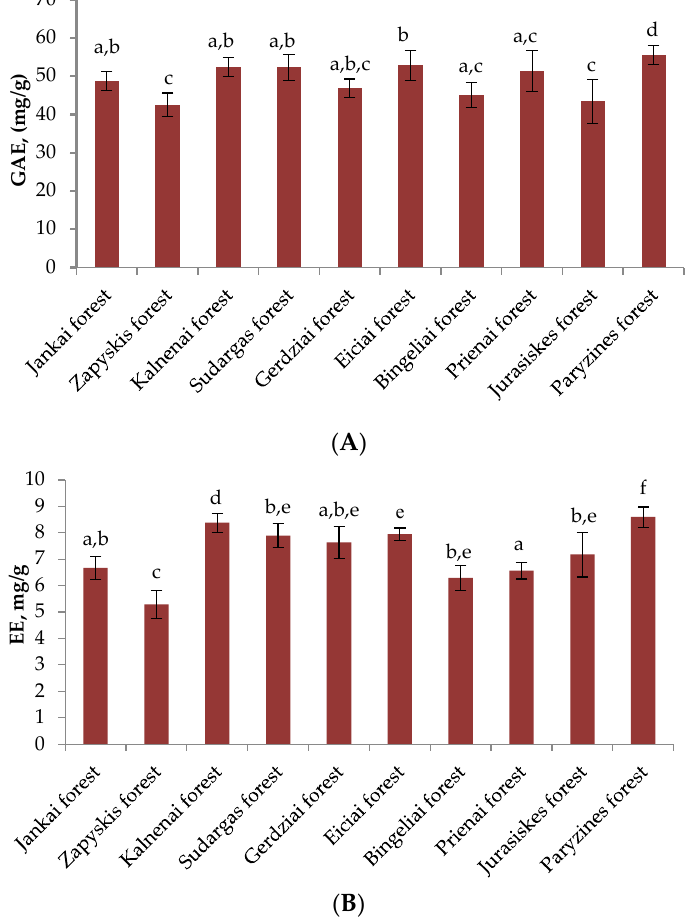
Figure 1. ( A ): variation of total phenolic compounds (mg/g) content of heather samples in different habitats; ( B ): variation of total proanthocyanidins (mg/g) content of heather samples in different habitats. Different letters indicate statistically significant differences between heather samples ( p <